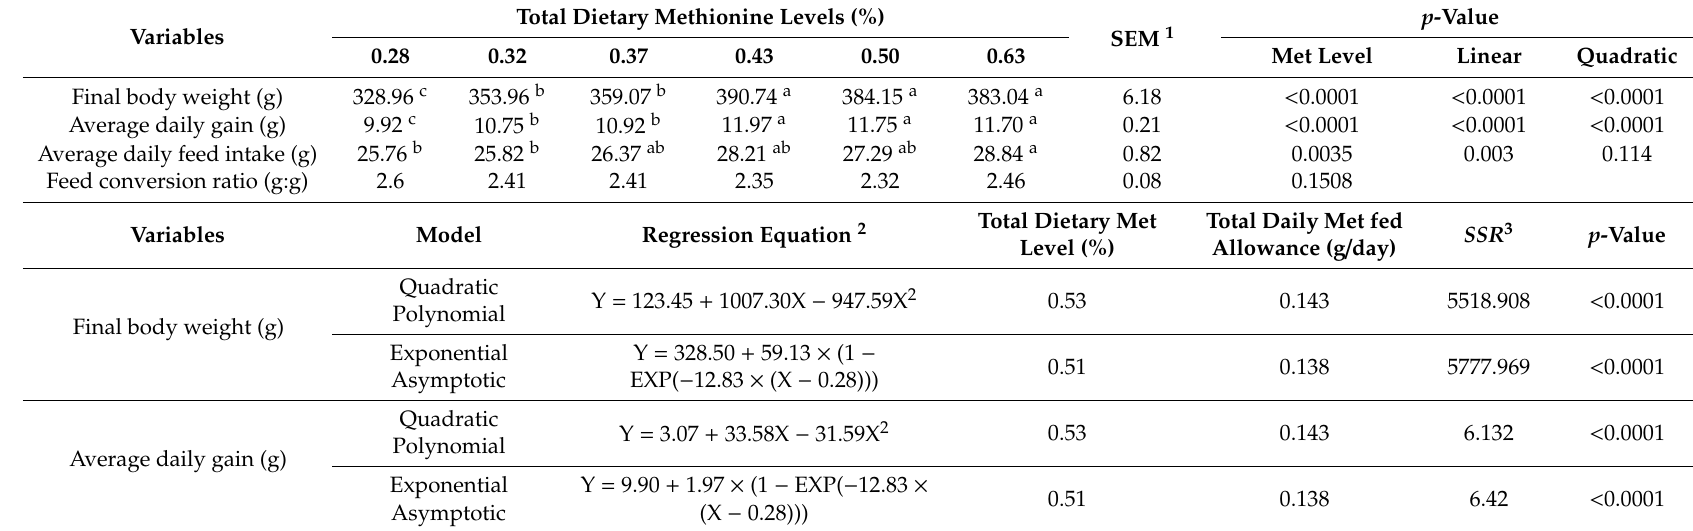
Table 5. E ff ects of total dietary methionine level on growth performance of male Guangxi yellow-feathered chickens aged 1 to 30 days. Variables